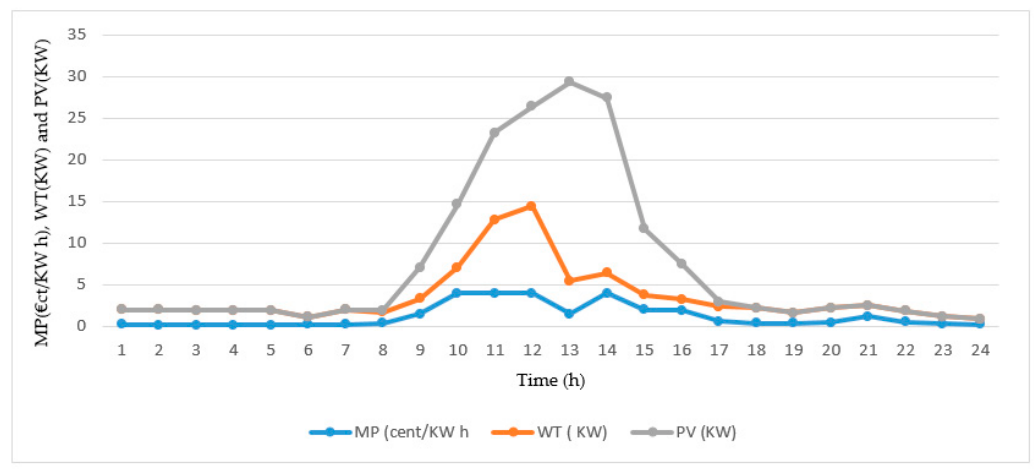
Figure 11. The forecast values of the market prices and the generation power of the wind turbines and the photovoltaic panels.